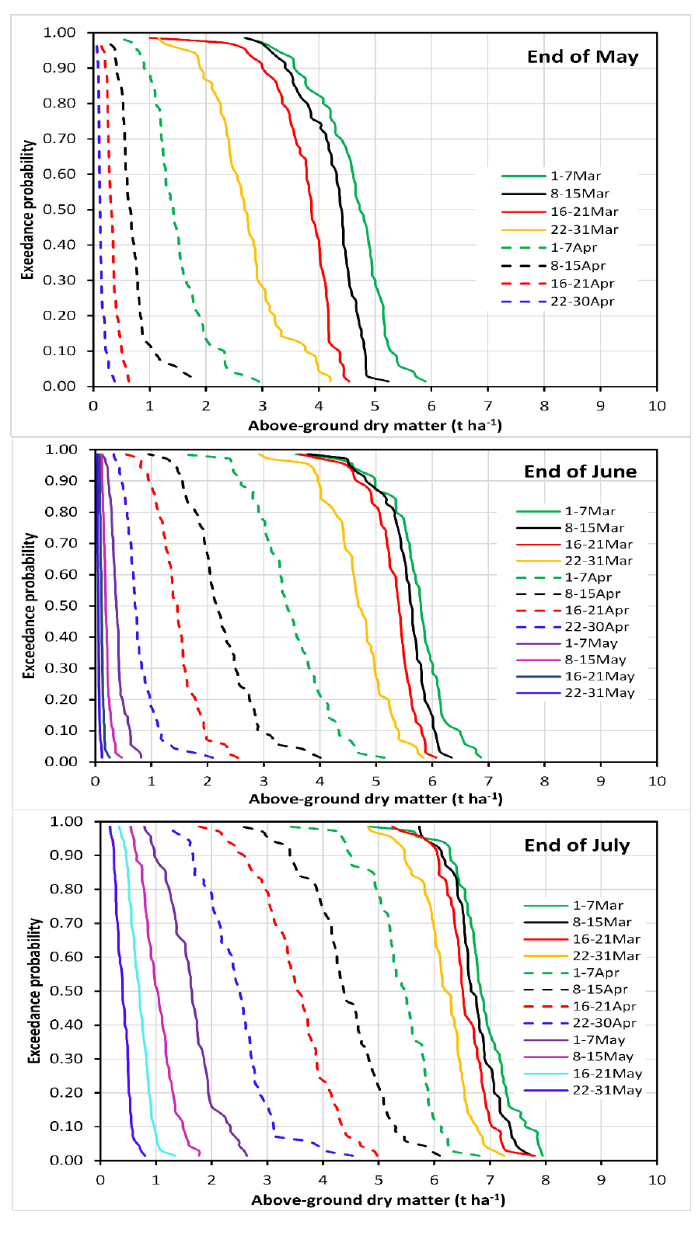
Figure 6. Exceedance probability of above-ground dry matter at different grazing times (end of May, end of June, and end of July) for a dual-purpose winter wheat sown from the first week of March to the last week of May.